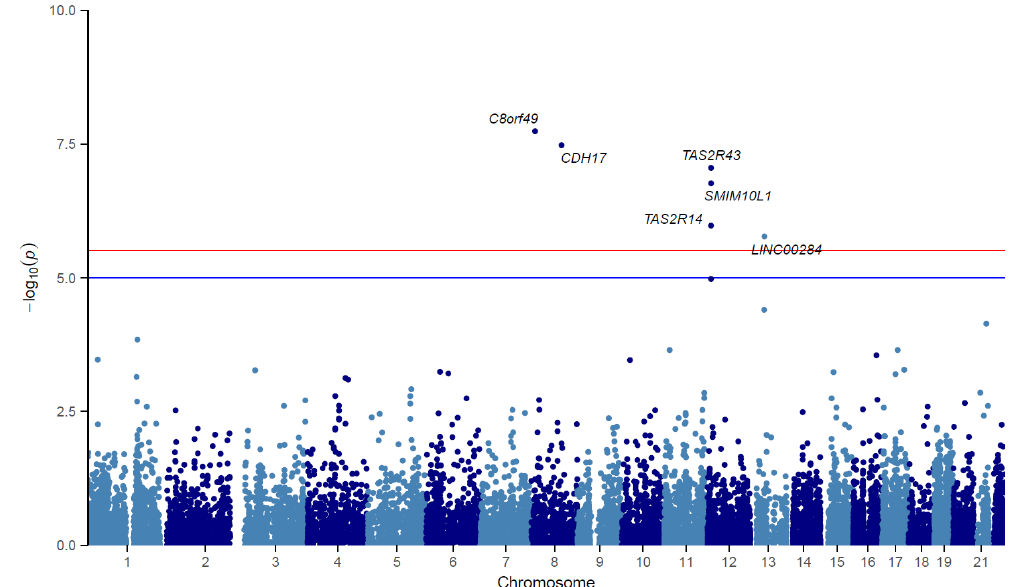
Figure 3. Manhattan plot of TWAS of ECC depicting transcripts associated with the condition. The horizontal red line represents the genome ‐ wide significance threshold ( p = 3.09 × 10 − 6 ), and the horizontal blue line represents the suggestive significance threshold ( p = 1.00 × 10 − 4 ). Each point represents a transcript tested for association with expression imputed from the ECC GWAS meta ‐ analysis. The x ‐ axis is the genomic position of the gene corresponding to the transcript tested, and the y ‐ axis is the negative logarithm of the ECC association p ‐ value. The six transcripts surpassing significant p ‐ value thresholds are annotated. TAS2R43, SMIM10L1 , and TAS2R14 are located at the same locus.